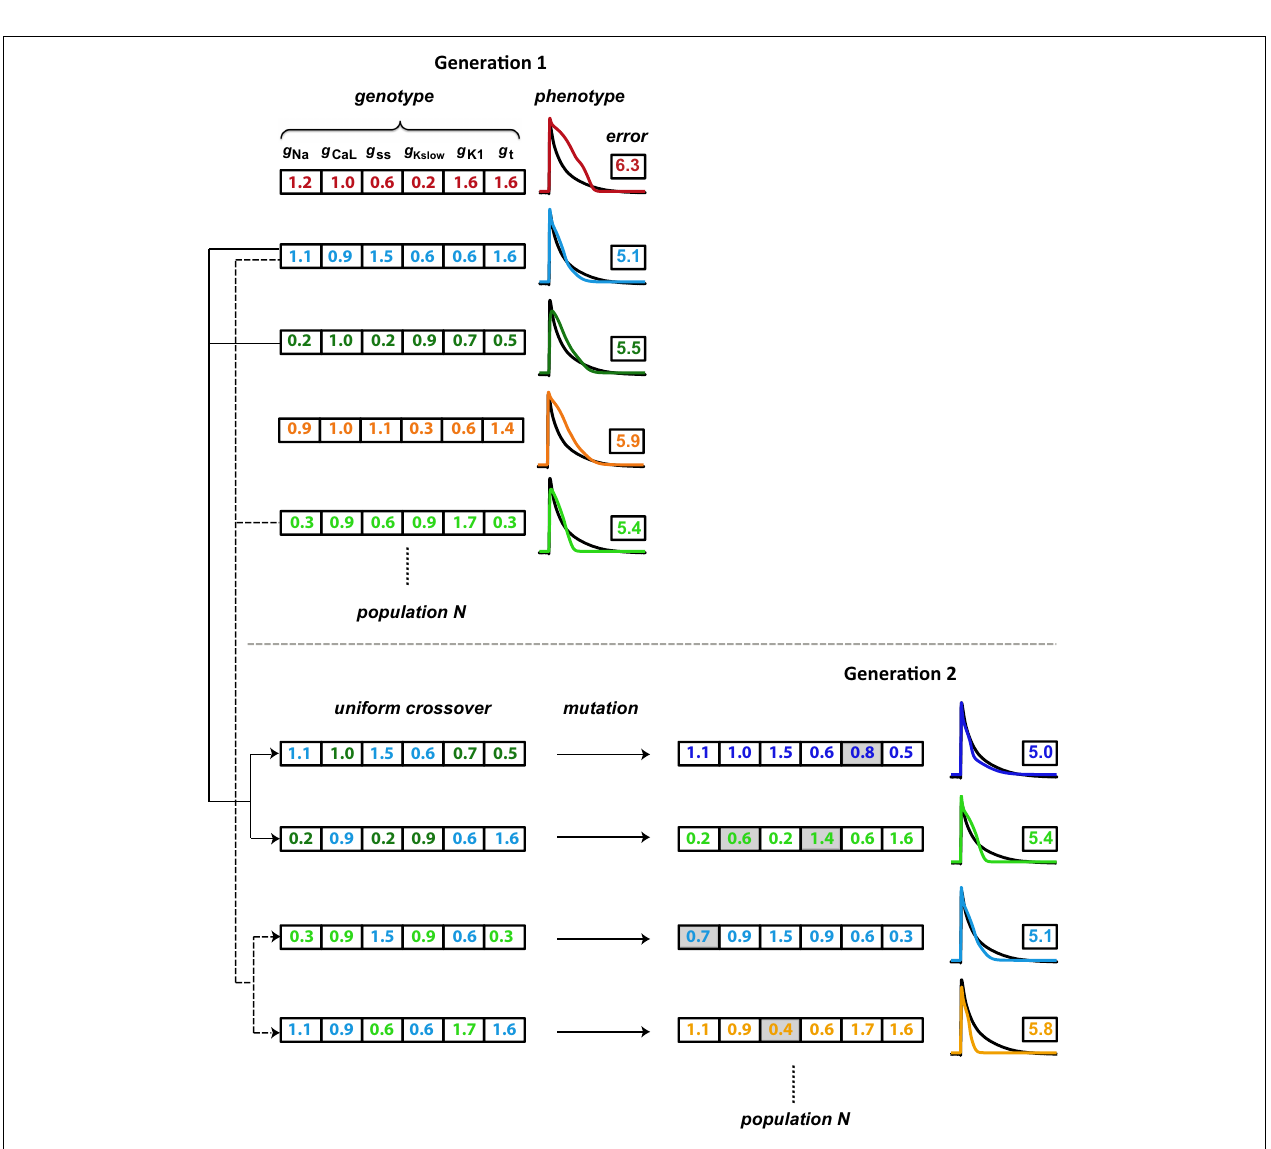
process known as crossover, to generate two children whose genotypes consist of values inherited from their parents. A second step introduces variation (mutations; gray shading) in these gene values. Finally, the offspring phenotype and associated error value are evaluated.These processes of parent selection, crossover, mutation, and offspring generation and evaluation are repeated to obtain the desired number of individuals in the subsequent generation. In our optimizations, the GA cycles through 15